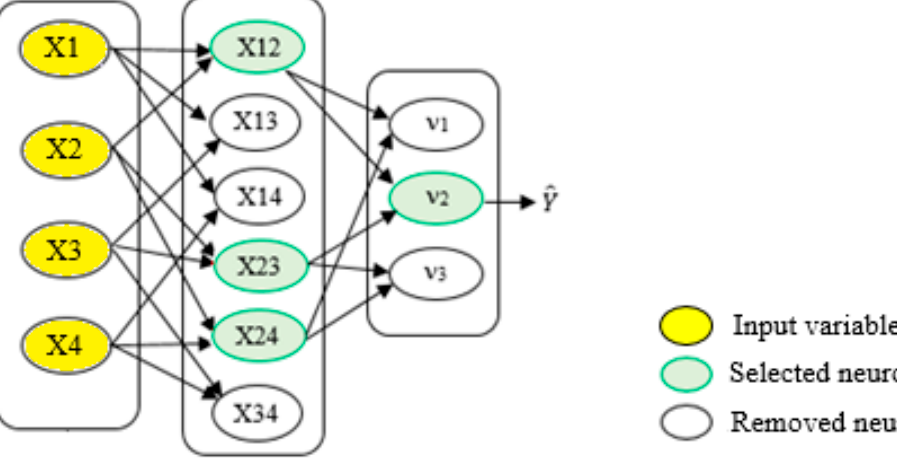
Figure 3. The structure of the GMDH model with four input variables.